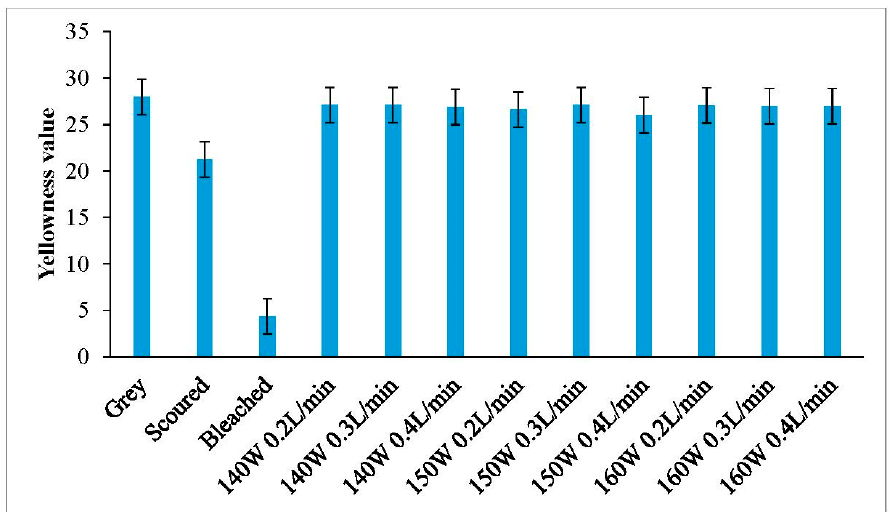
Figure 8. Yellowness values of interlock fabric.